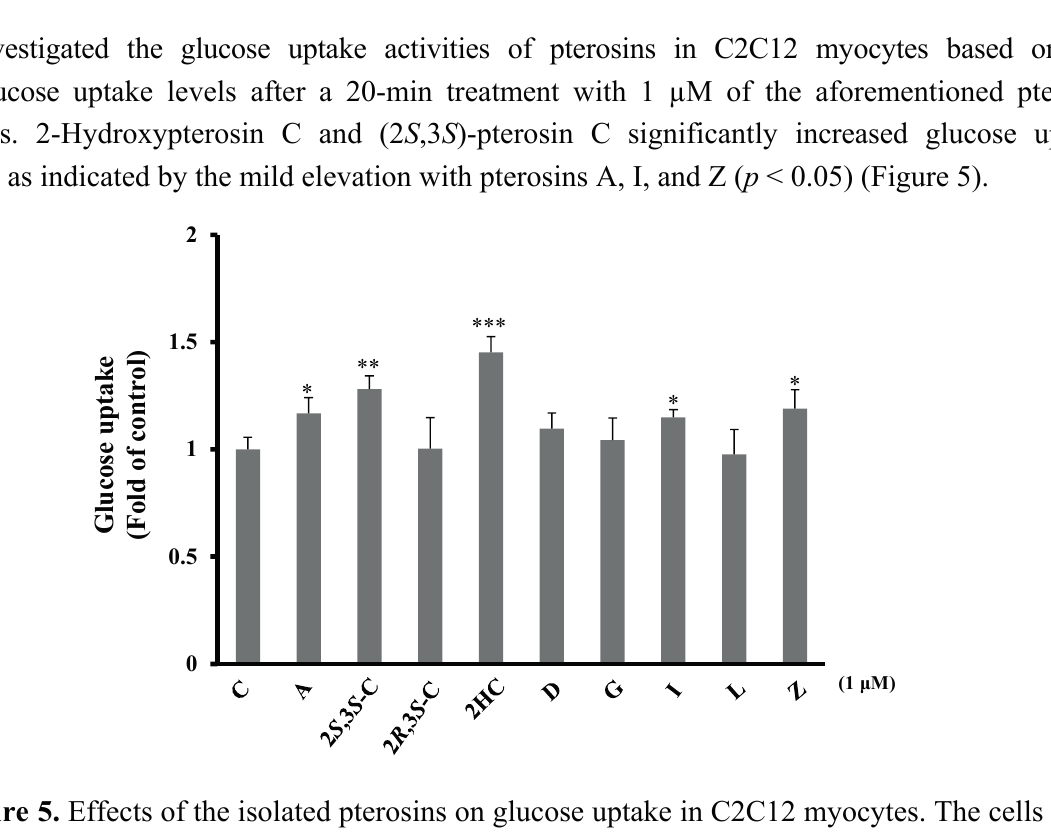
Figure 5. Effects of the isolated pterosins on glucose uptake in C2C12 myocytes. The cells were treated with the test compounds (1 μ M) and 2-deoxy- D -[ 3 H] glucose was added to determine the glucose uptake activity. * p < 0.05, ** p < 0.005, *** p <